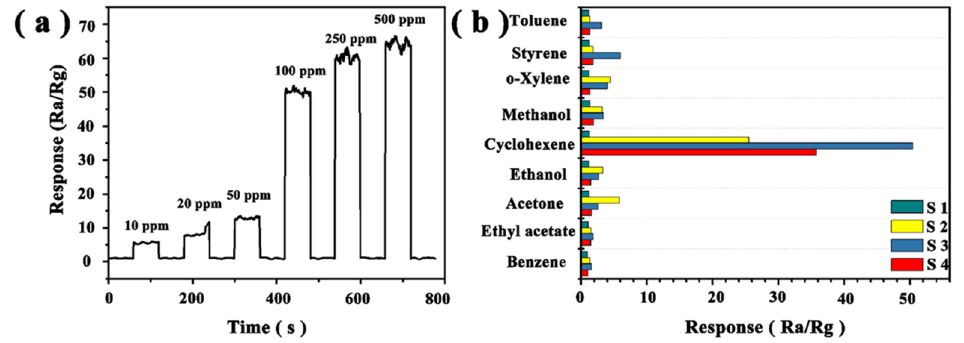
Figure 7. ( a ) Gas response recovery of S3 toward cyclohexene within the concentration range of 10–500 ppm at 300 ◦ C; ( b ) gas response of WO 3 · 0.33H 2 O-based samples toward 100 ppm of different test gases at 300 ◦ C.